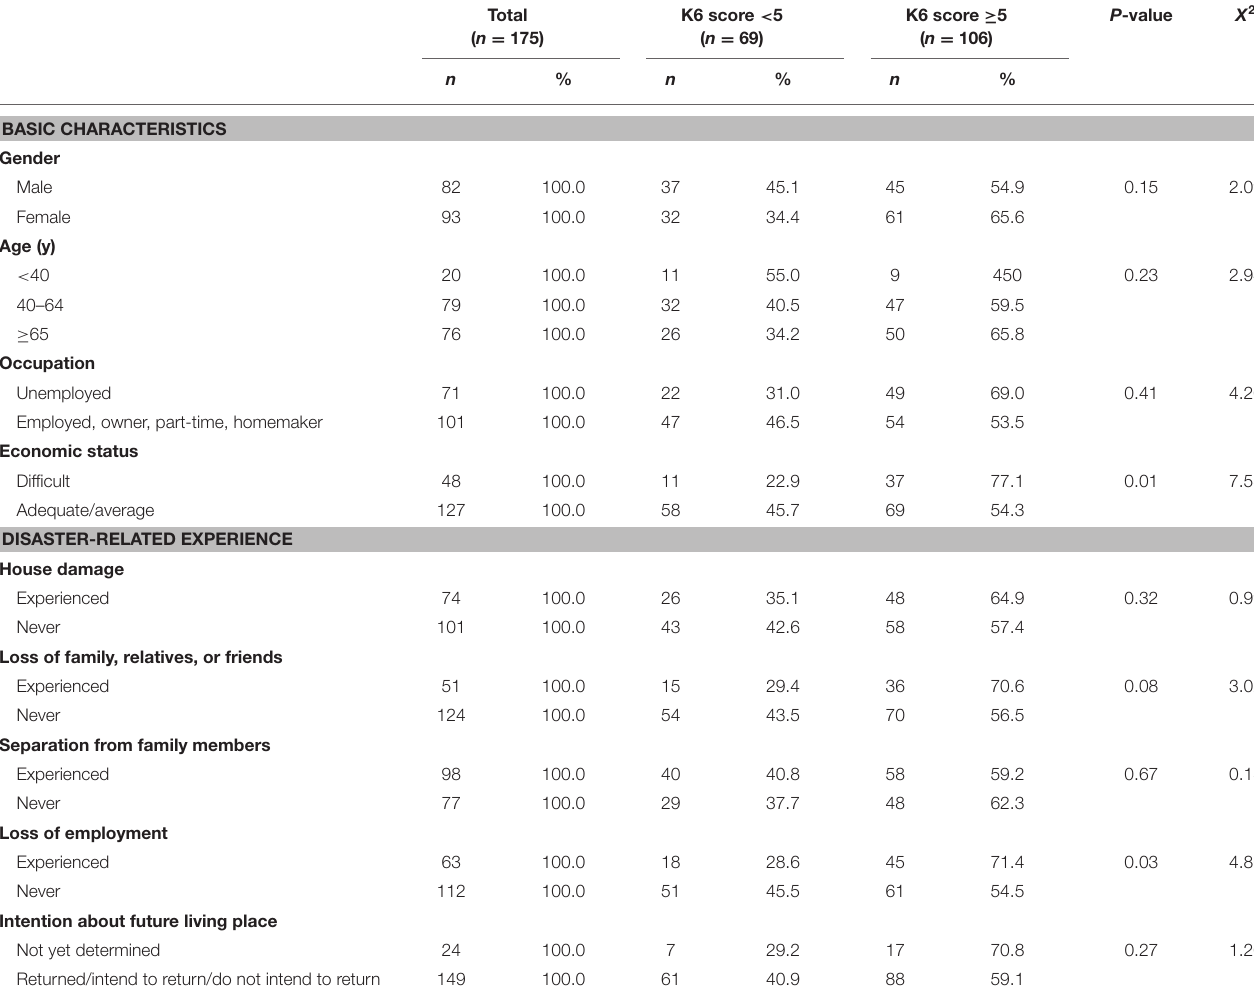
TABLE 2 | Basic characteristics and disaster-related experiences of the